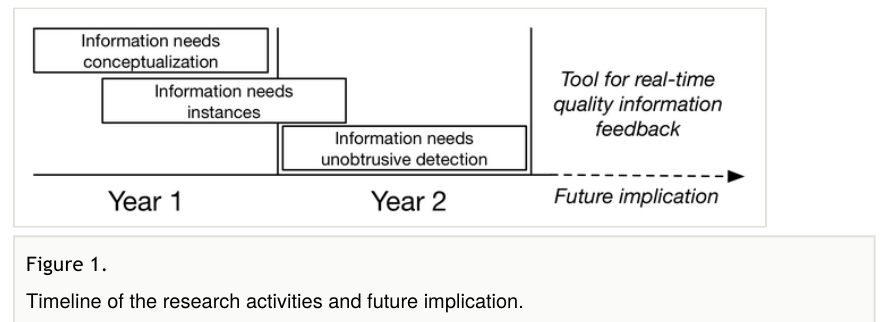
Figure 1. Timeline of the research activities and future